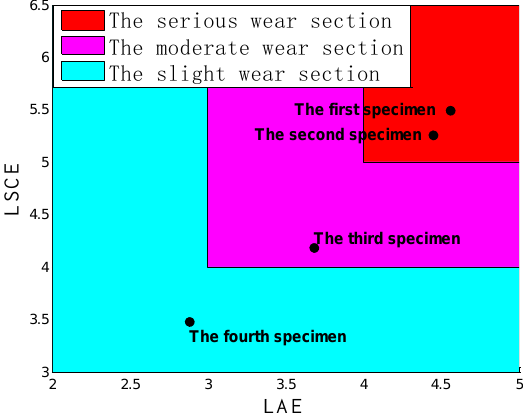
Figure 15. Quantification of wear degree in four specimens.